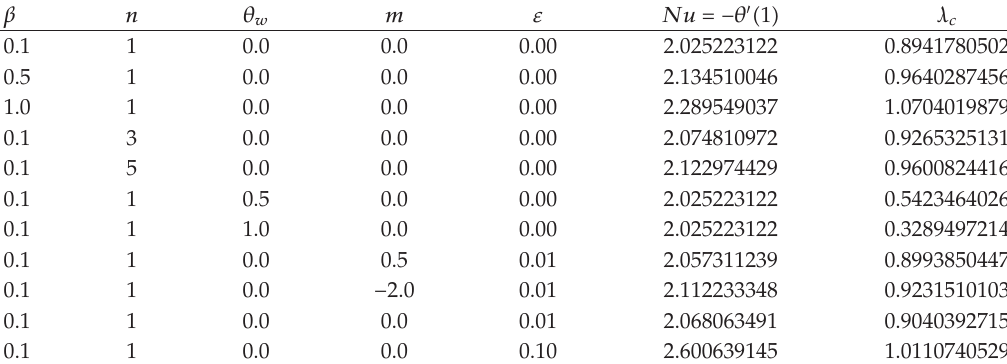
Table 2: Computations showing thermal ignition criticality for di ff erent parameter